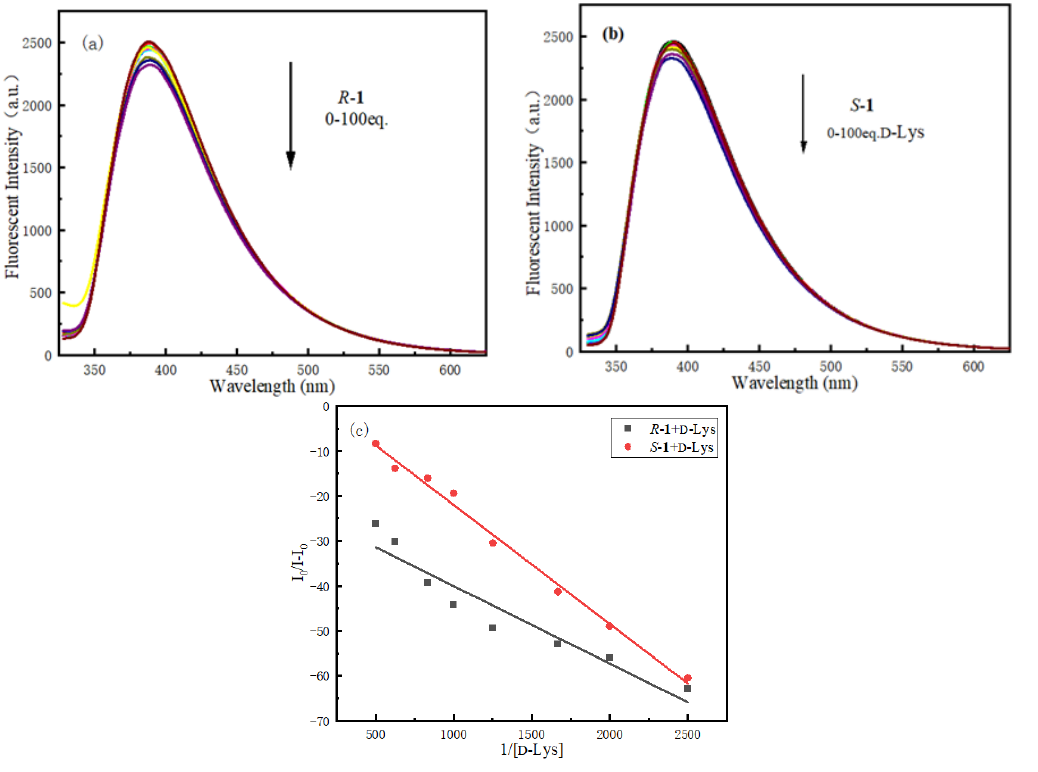
Figure 8. ( a , b ) Fluorescence spectra of R - 1 and S - 1 (2.0 × 10 − 5 M in CH 3 OH) upon titration with D-Lys (1.0 × 10 − 3 M); ( c ) Benesi–Hildebrand plots of R - 1 and S - 1 titration with